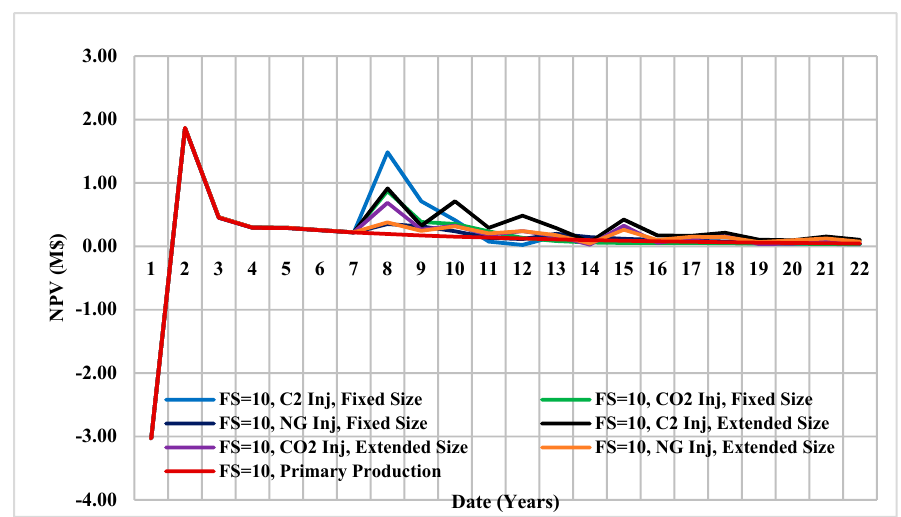
Figure 23. Cumulative NPV of the scenarios for fixed and extended cycles of cyclic CO2, C2 and NG injection as well as natural depletion, FS=30, Oil API=38.